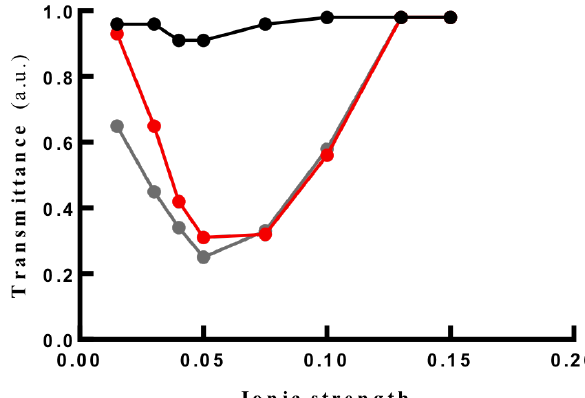
Figure 4. Dependence of the solubility, measured as transmittance, from ionic strength for binary mixtures of alginate and lactose-modified chitosan at a weight ratio of polyanion over polycation of 0.75 (black), 0.25 (red), and 0.15 (grey). Data redrawn from [25].